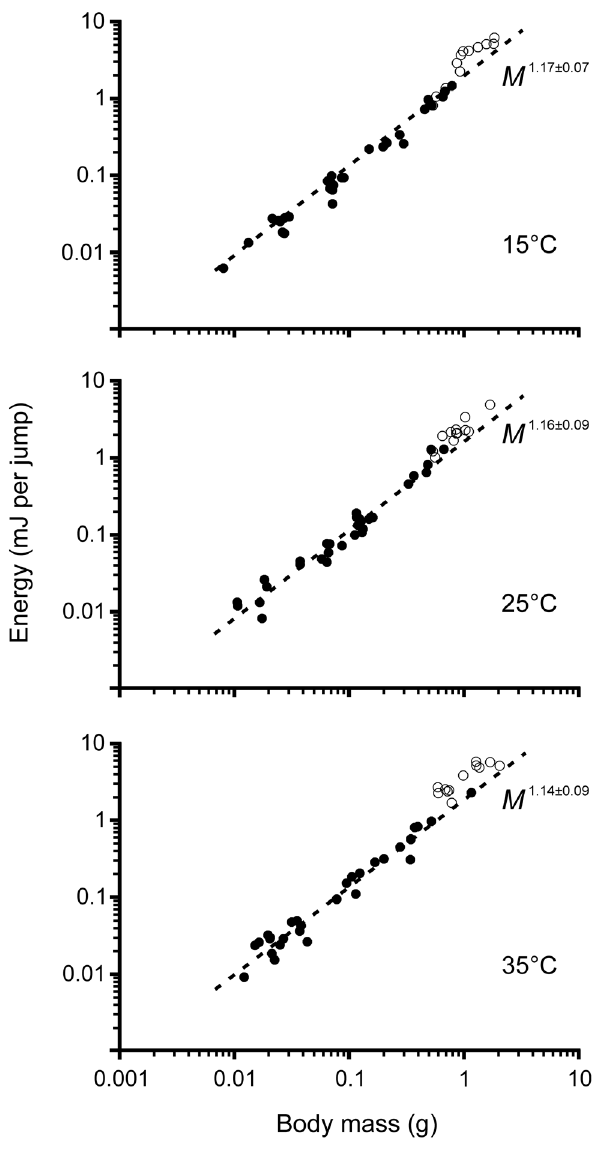
Figure 1. Effect of temperature on the allometric relationship between jump energy and body mass across the five juvenile life stages of Locustamigratoria (filled circles; N =30 juvenile individuals per temperature, N =90 juvenile individuals in total). Adult jump energy is also presented (unfilled circles; N =12 adult individuals per temperature, N =36 adult individuals in total), but is not included in the regression due to their disproportionately high values.